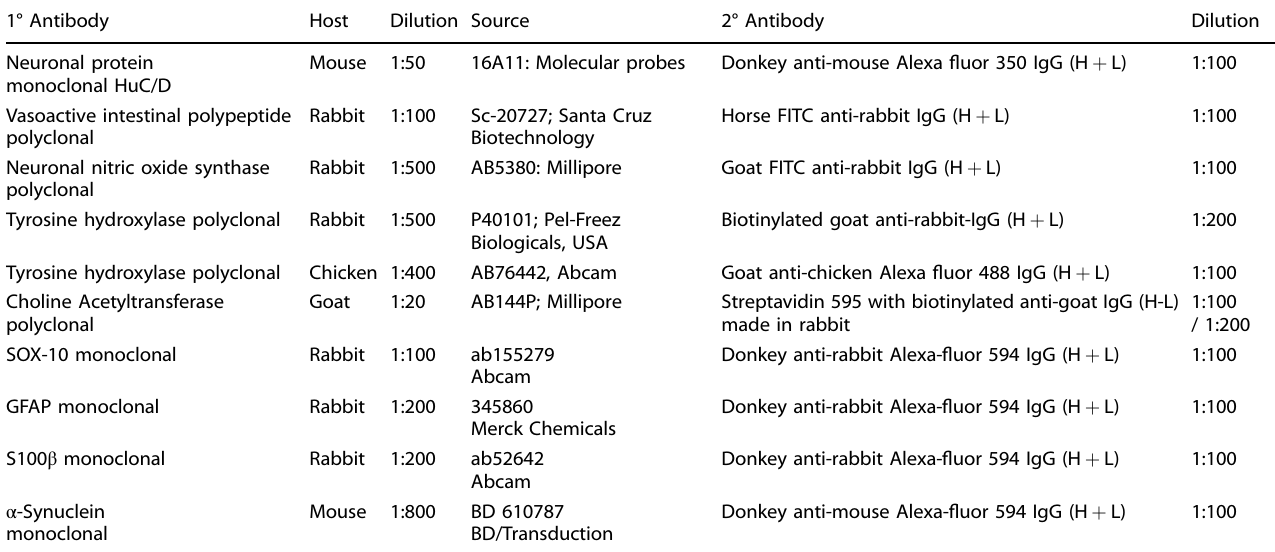
Table 2. Primary and secondary antibodies, their sources and